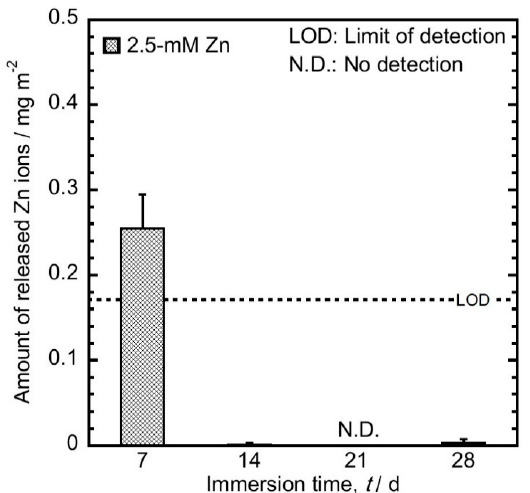
Figure 6. The amount of Zn ions released into saline every week from Ti MAO-treated in the electrolyte containing 2.5-mM Zn ( n = 3).